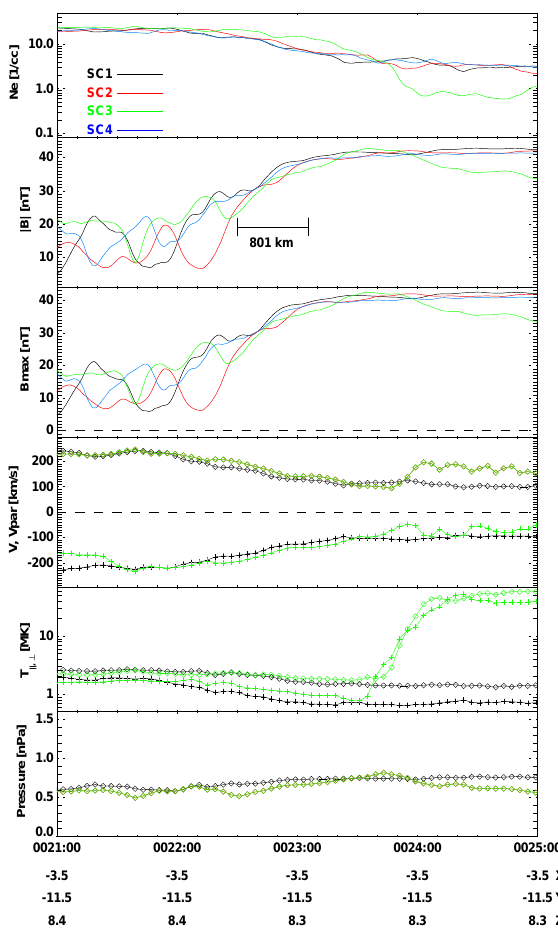
Fig. 5. Plasma and magnetic field data for the inbound crossing near 00:22 UT on 5 July 2001, in the same format as Fig. 4. Note that C3 enters the hot plasma of the plasma sheet near 00:24